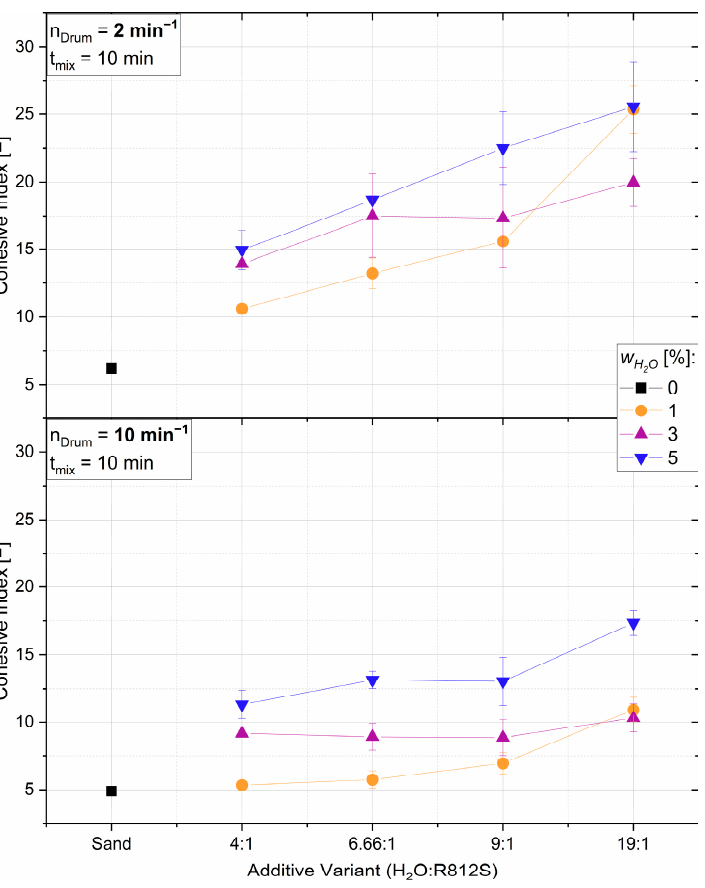
Figure 9. Cohesive index for mixtures containing different variants of dry water at the drum rotating speeds: n = 2 min − 1 ( top ) and n = 10 min − 1 ( bottom ).